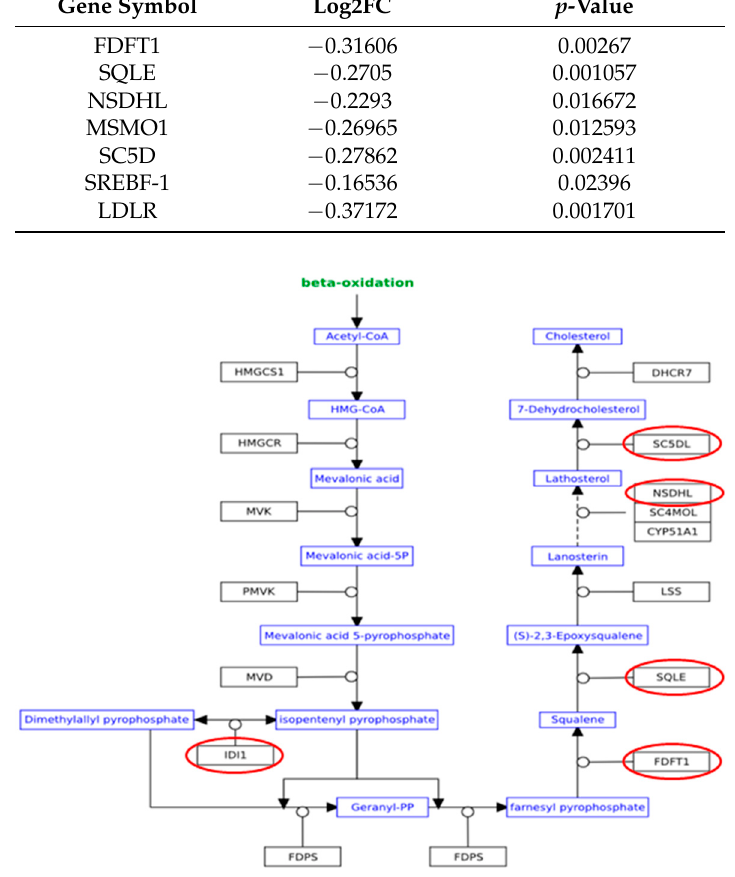
Figure 4. Cholesterol biosynthesis pathway. Downregulated DEGs (red ellipse) in veal calves fed with a GP-supplemented diet ( p < 0.05). FDFT-1: Farnesyl-diphosphate Farnesyltransferase; SQLE: Squalene Epoxidase; NSDHL: NAD(P)-dependent Steroid Dehydrogenase- like ; SC5D: Sterol-C5-